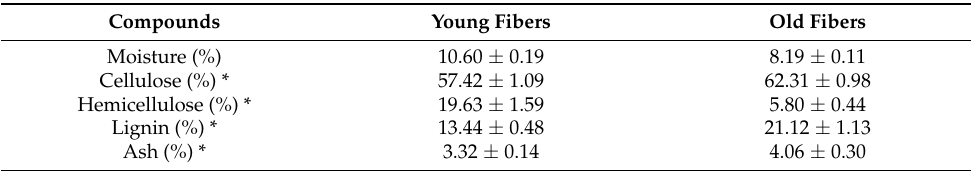
Table 1. Physicochemical characterisation of young and old cellulosic